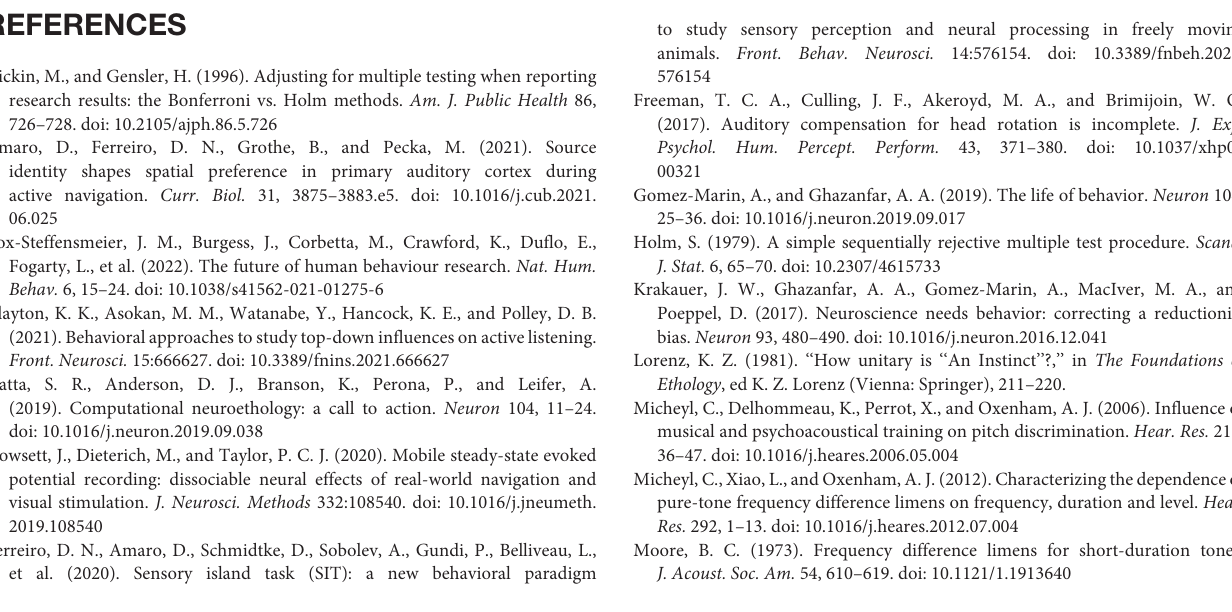
Supplementary Figure 1 | (A) Normalized years of musical experience. (B) Distribution of last frequency heard across subjects. Both panels: the subjects are ordered by ascending median LFH. Pearson correlation of musical experience and median LFH: rho = -0.38; p = 0.12. (C) Pearson correlation of musical experience and LFH across all trials. (D) Same as (C) but removing four subjects with zero musical experience.